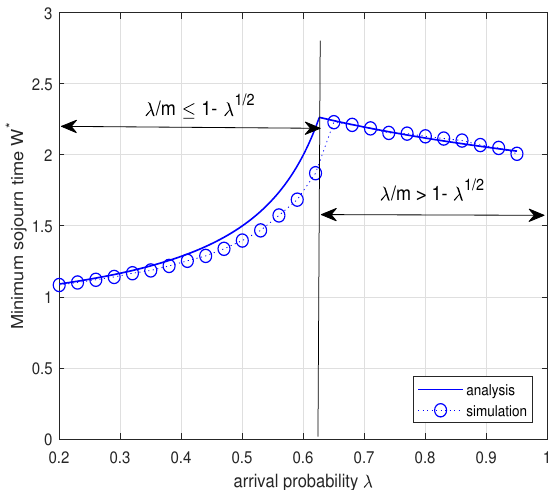
√ ≤ 1 − λ and µ 1 = 1 m